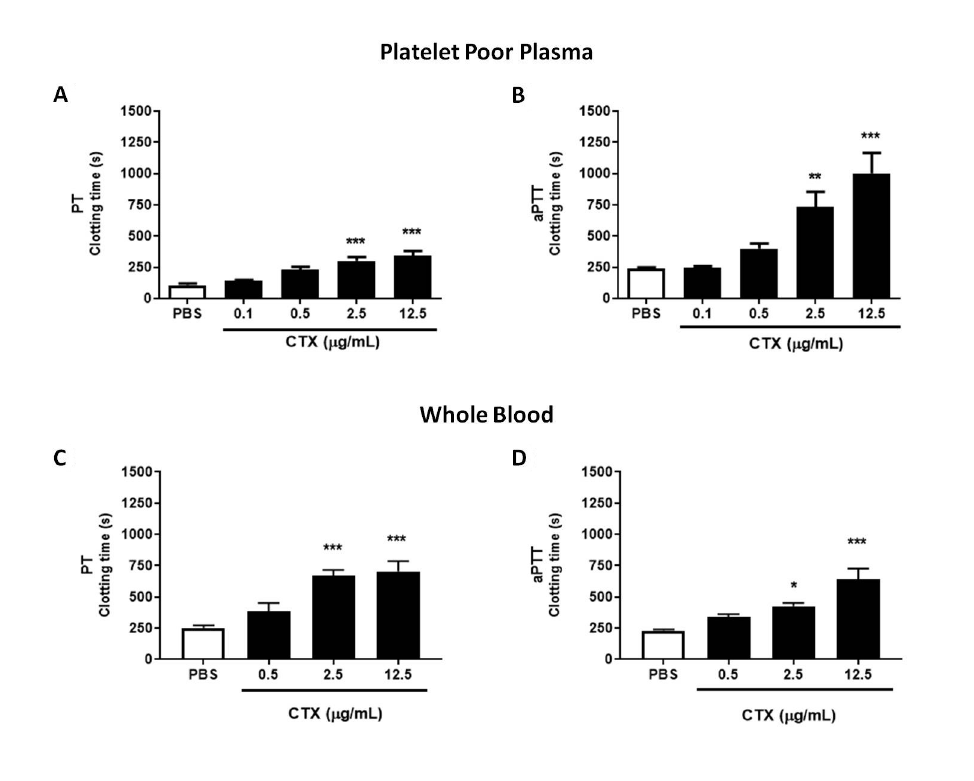
Figure 1. Whole blood and PPP clotting time. (A and B) PPP was incubated with CTX (0.1-12.5 µg/mL) or PBS (control). (C and D) Whole blood was incubated with CTX (0.5-12.5 µg/mL) or PBS (control), and PPP was obtained after incubation period. Clotting time was evaluated by (A and C) prothrombin time (PT) and (B and D) partial activated thromboplastin time (aPTT). The results are expressed as mean clotting time (s) ± SEM. The groups were performed with n = 6, where ***p < 0.001, **p < 0.01 and *p < 0.05 vs. control group. Statistical analysis was performed using one-way ANOVA followed by Dunnett’s